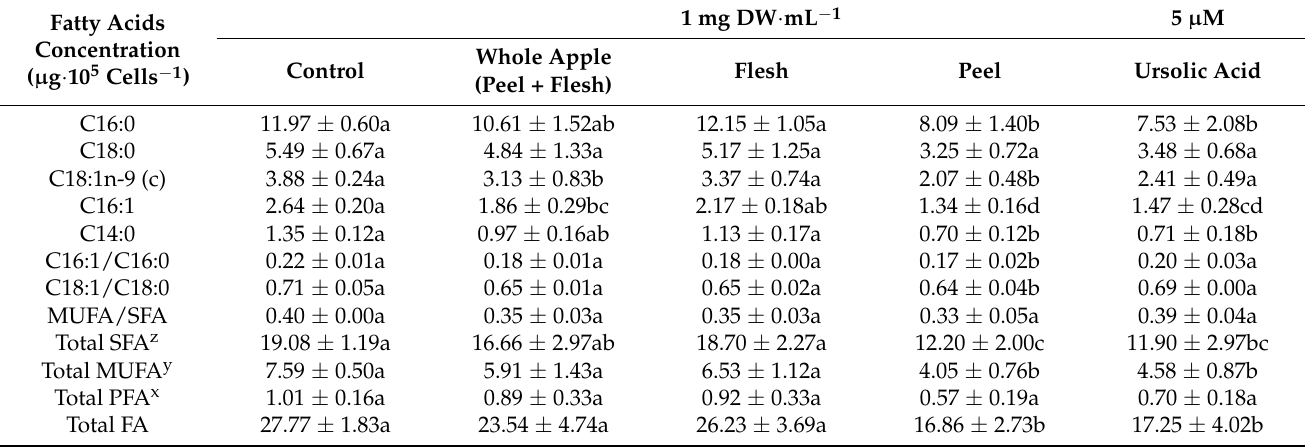
Table 2. Quantified fatty acid concentrations of 3T3-L1 cells after treatment with 70% methanol (1 mg dry powder in 1 mL of DMSO) for extracts of “Fuji” pre-washed apple ( Malus pumila Mill) or ursolic acid 5 µ